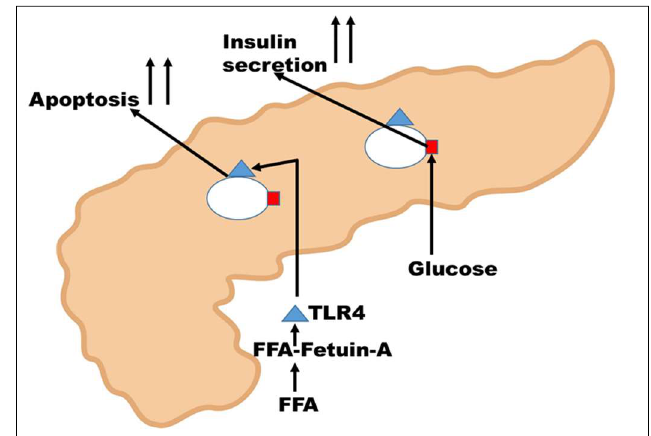
Figure 4. Fetuin-A-mediated insulin resistance in the pancreas. High glucose initiates insulin secretion by the islet cells. Free fatty acids such as palmitate initiate their signals in the infiltrating adipocytes via TLR4, resulting in upregulation of cytokine synthesis, culminating in the apoptosis of islets cells and reduced insulin secretion.